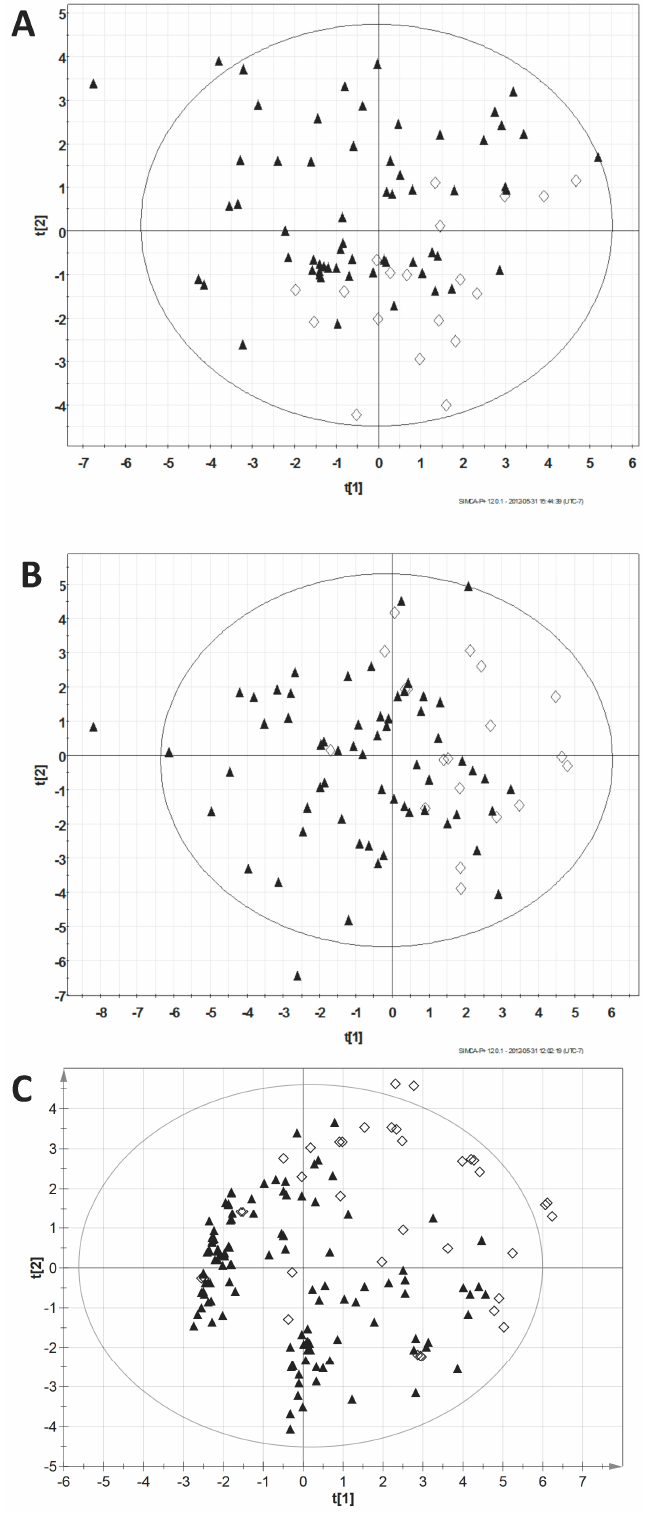
Figure 1. Principal components analysis (PCA) results. Scatter plots showing scores (t) in first two components of PCA models for one training dataset (( A ) 1 H-NMR; ( B ) GC-MS; ( C ) Combined). Results from other training sets were similar. Plots coded for patient diagnosis: malignant: ▲ vs. benign: ♦